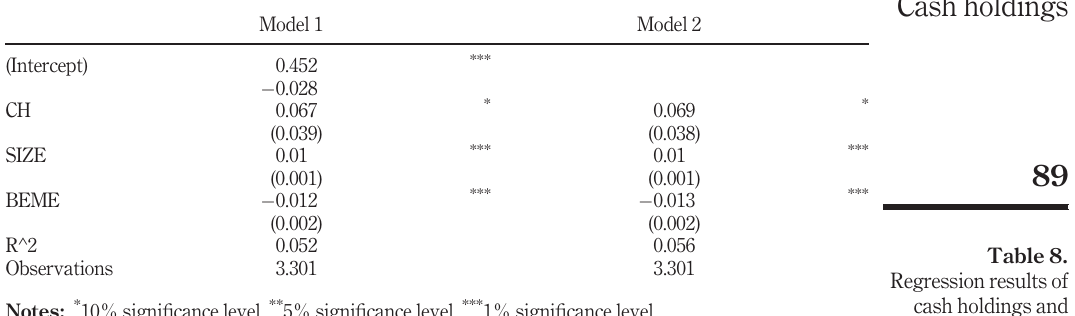
Table 8. Regression results